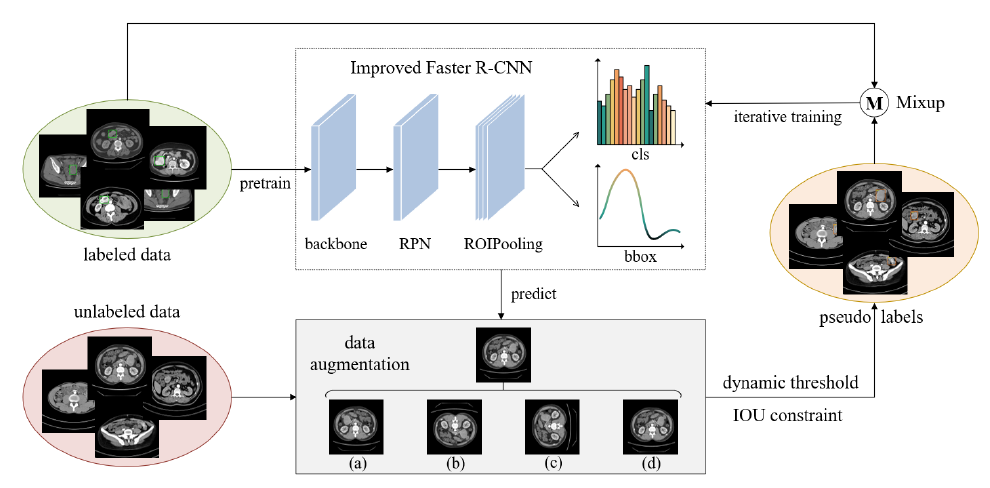
Figure 1. Overview of the self-training method. In each iteration, the predictions of the Improved Faster R-CNN on unlabeled data are augmented and then filtered out with the IOU constraint and the dynamic threshold together to generate pseudo-labels. The labeled data and the pseudo-labeled data are linearly mixed using Mixup, and the resulting new dataset is used for the next iteration. The data augmentation methods in the figure are (a) horizontal flip, (b) vertical flip, (c) rotation, and (d) affine transformation; one is randomly selected as the data augmentation method and repeated k times during the